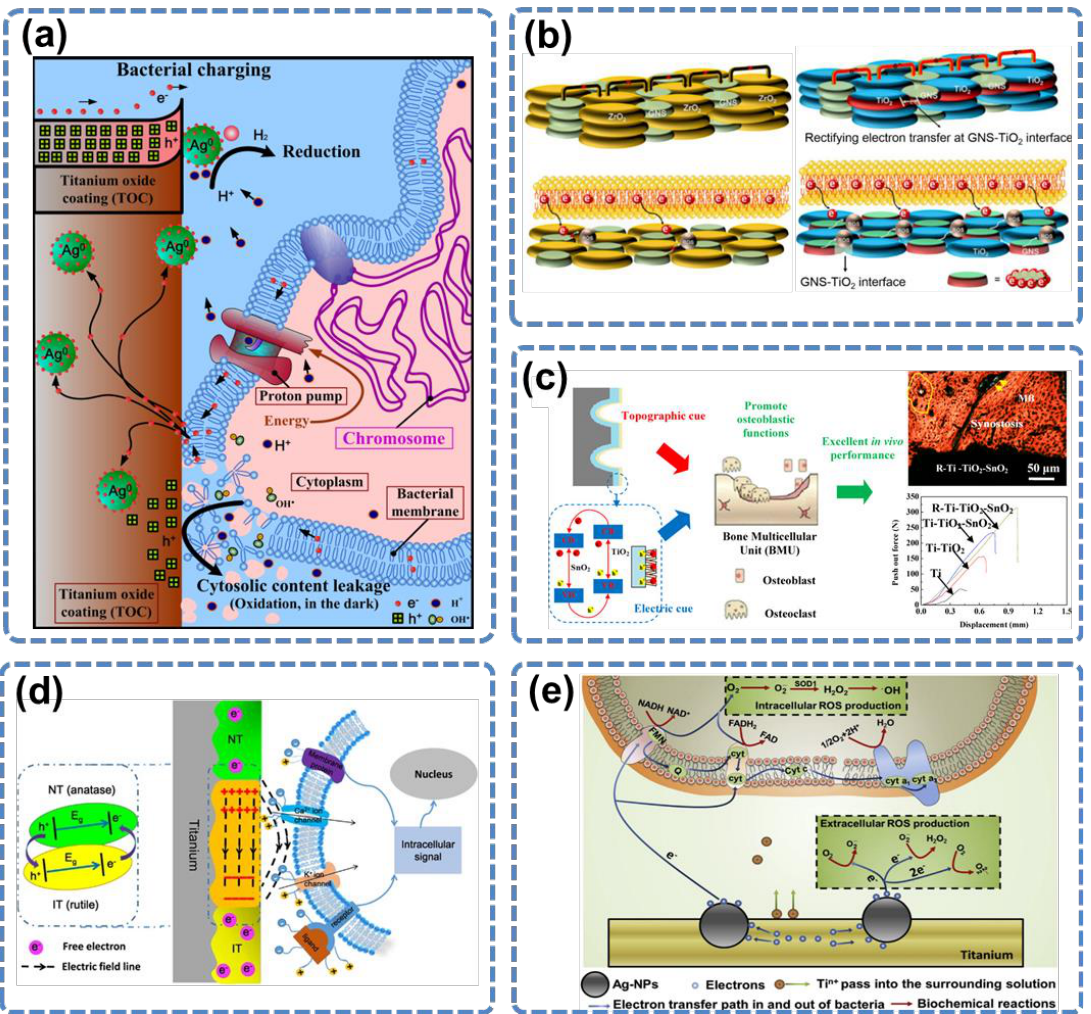
Figure 6. ( a ) Extracellular electron transfer induces bactericidal action of the Ag@TiO 2 coating. Reprinted with permission from Ref. [89]. Elsevier, 2013. ( b ) The proposed mechanism explaining the antibacterial property of graphene nanosheets-TiO 2 coatings is based on the electron transfer at the graphene-TiO 2 interface. Reprinted with permission from Ref. [94]. Elsevier, 2020. ( c ) Illustration of the enhanced osteogenesis performance of titanium by an electric cue offered by the built-in electrical field of SnO 2 –TiO 2 . Topographic cue (red color arrow) and electric cue (blue color arrow) enhance the in vivo osteogenesis process (green color arrow). Reprinted with permission from Ref. [95]. American Chemical Society, 2018. ( d ) Demonstration of the mechanisms to generate MEF and the interactions between MEF and stem cells. Reprinted with permission from Ref. [97]. Springer Nature, 2016. ( e ) The electron transfer-based bacteria killing on the Ag@Ti surface. Reprinted with permis-